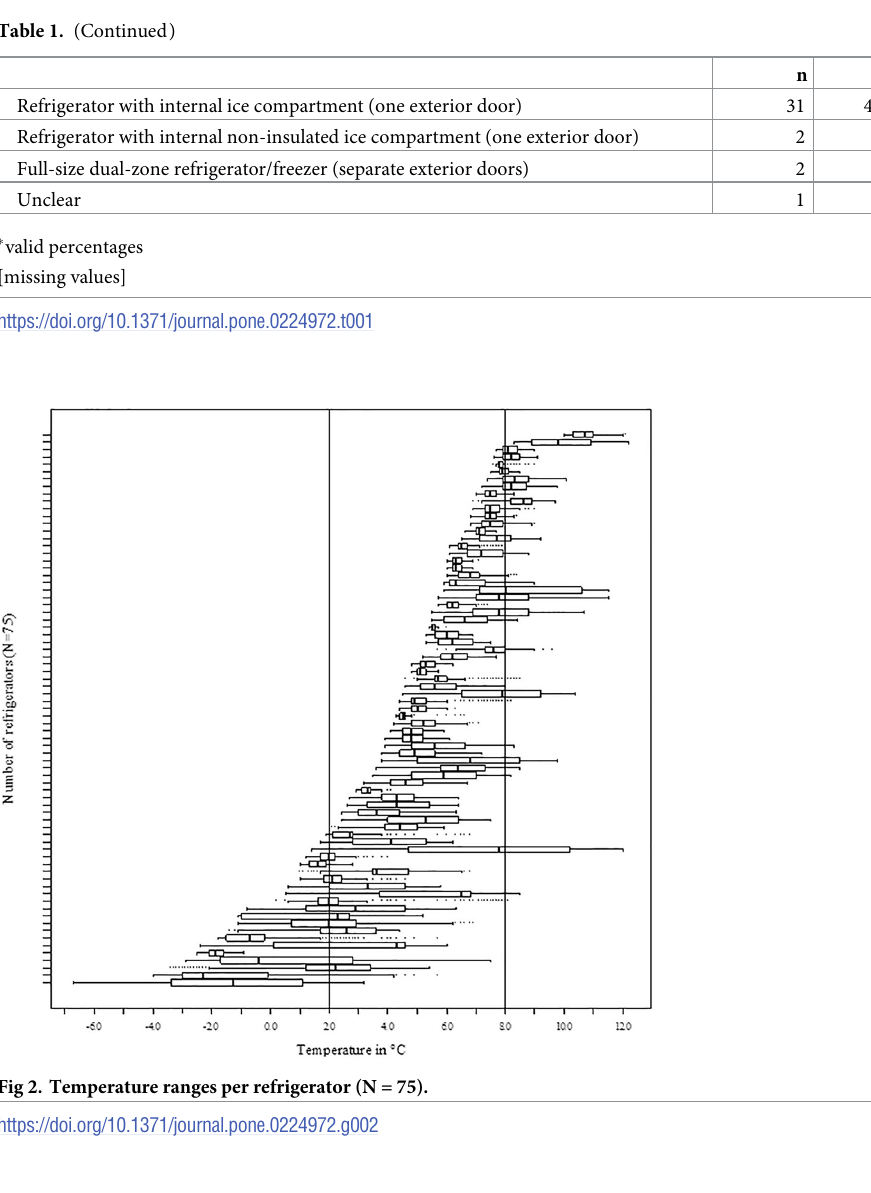
Table 2. Refrigerators categorised according to their ability to maintain the target temperature range, i.e. 2 to 8 ˚C (N =